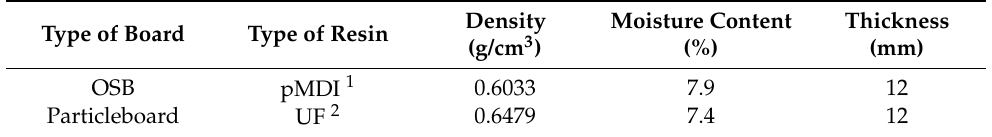
Table 1. Properties of tested wood-based panels.